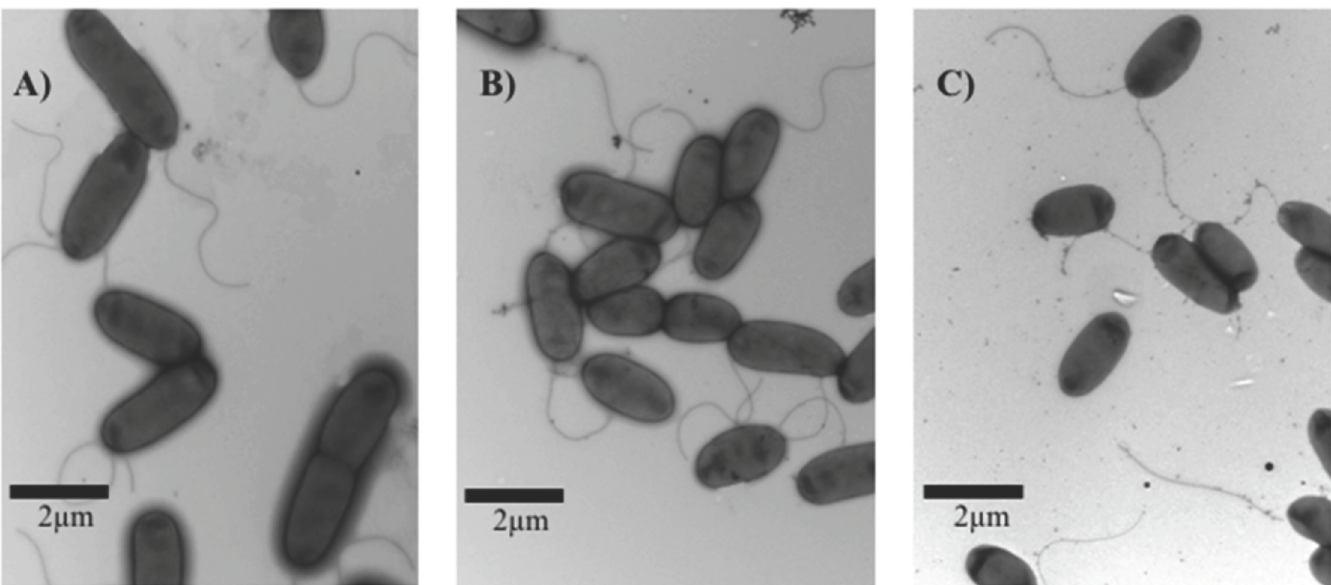
Fig 2. Representative images of cells captured using Transmission Electron Microscopy (TEM). Briefly, BM2 swarm plates ( ± 0.75 μ g/ml 1018) were inoculated with 1 μ l of planktonic cells suspended at an OD 600 of 0.4–0.6 in BM2 and then incubated for 20 h at 37˚C. Cells were transferred to a mesh grid for TEM. (A) Actively swarming WT cells from the edge of a swarming colony. (B) Non-swarming cells taken from the centre of a swarming colony. (C) Cells from a swarming plate treated with 0.75 μ g/ml of